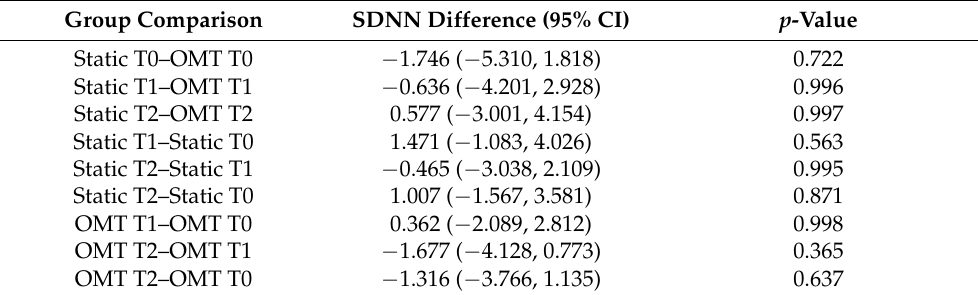
Table 4. Tukey post hoc tests regarding SDNN.